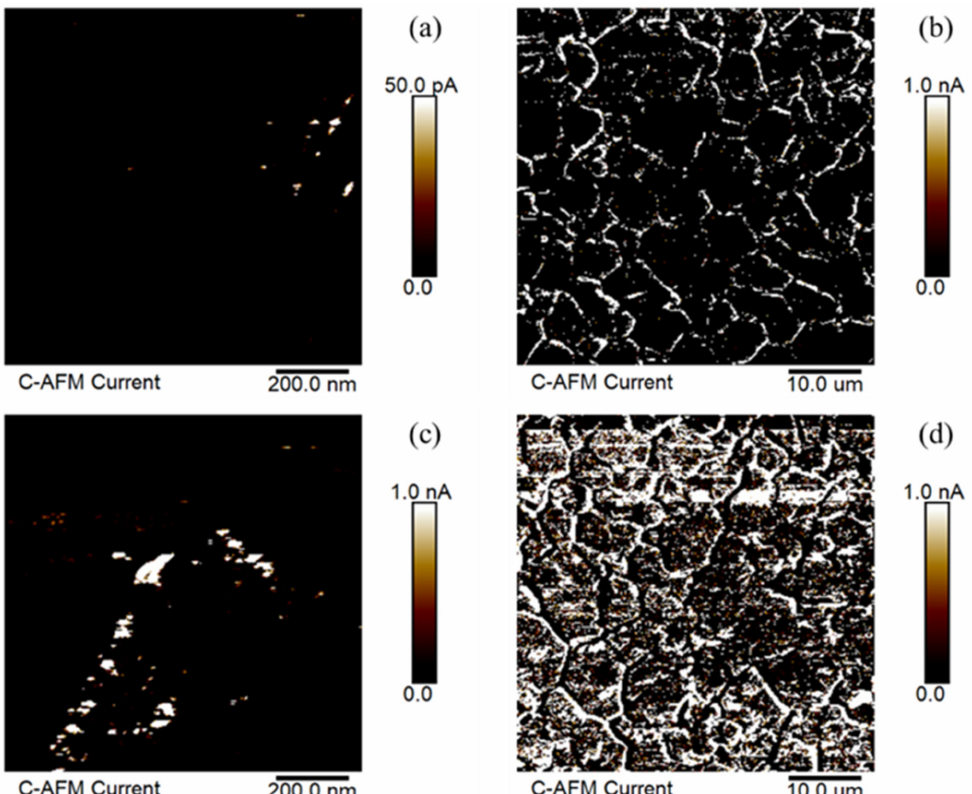
Figure 5. Conductivity of original and treated SS316L by AFM. ( a ) original SS316L before po- tentiodynamic tests; ( b ) original SS316L after potentiodynamic tests; ( c ) treated SS316L before potentiodynamic tests and ( d ) treated SS316L after potentiodynamic tests.